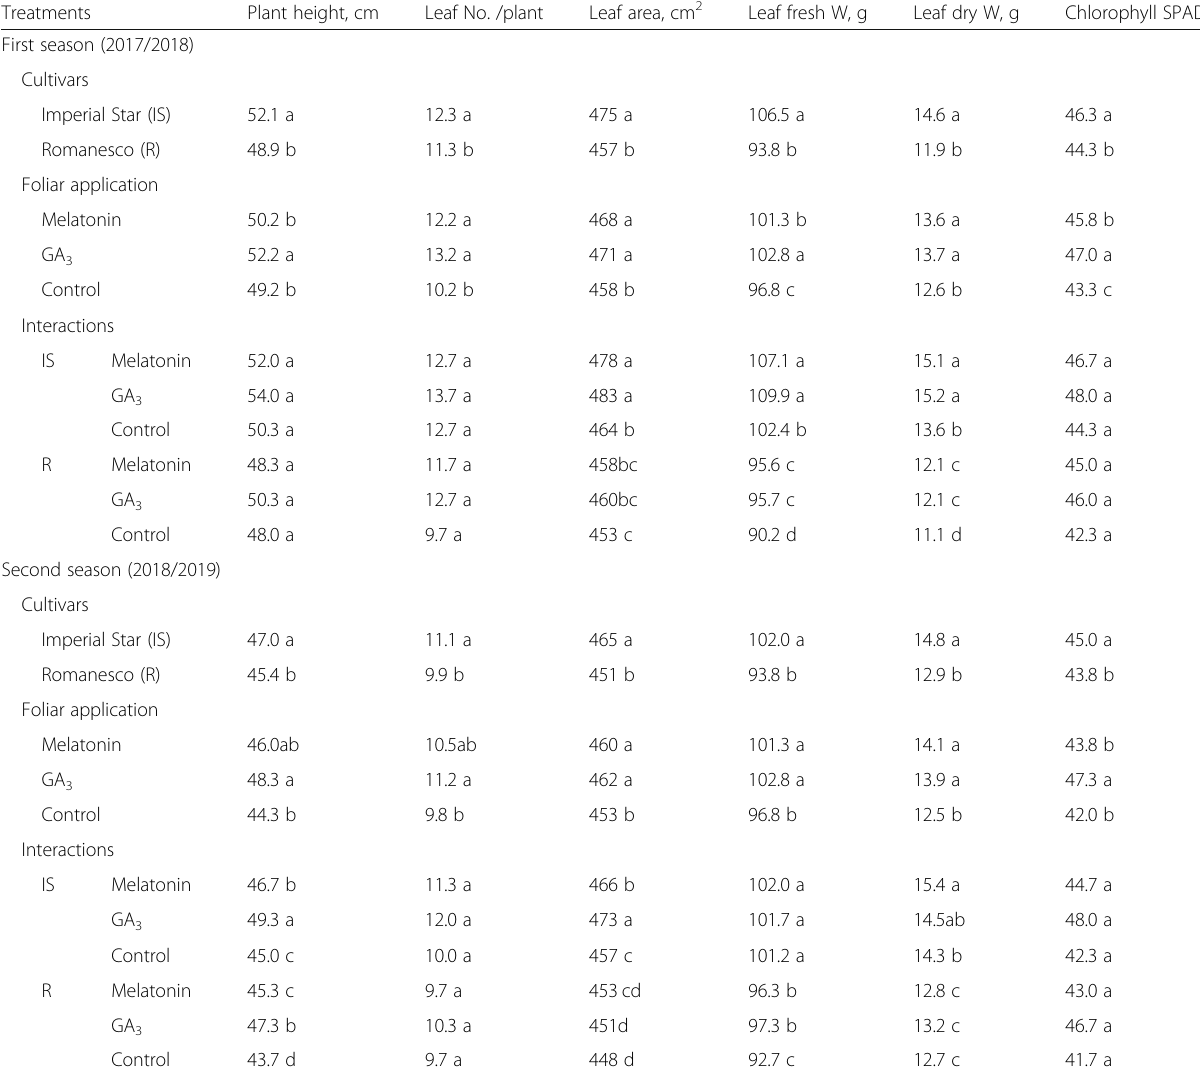
Table 1 Effect of GA 3 and melatonin on vegetative growth of two artichoke cultivars 70 DAT during the two growing seasons